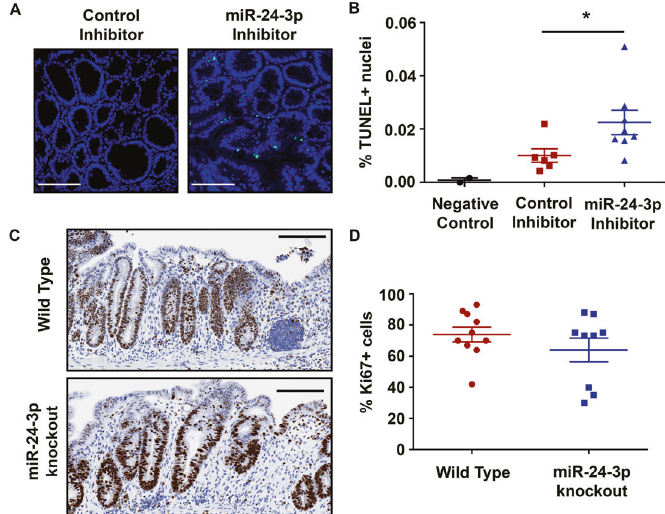
Fig. 4 Inhibition of miR-24-3p enhances intestinal epithelial cell apoptosis during the recovery from colitis. A , B After TUNEL labeling of Swiss rolls, the central and distal epithelium were annotated with software and the total number of TUNEL-positive nuclei (green) were quanti fi ed and compared to the total number of nuclei (blue). Scale bars = 100 µm. n = 4 mice for control inhibitor, n = 6 mice for miR-24-3p inhibitor from two independent experiments. Mean ± SD. * p < 0.05. C Representative Ki67 immunohistochemistry images of epithelial cells surrounding the ulcerated epithelium. Scale bars = 150 µm. D A graph representing a pathologist ’ s assessment of Ki67 positive cells surrounding the ulcer. n = 10 for wild type mice, n = 9 for miR-24-3p knockout mice from two independent experiments. Mean ±